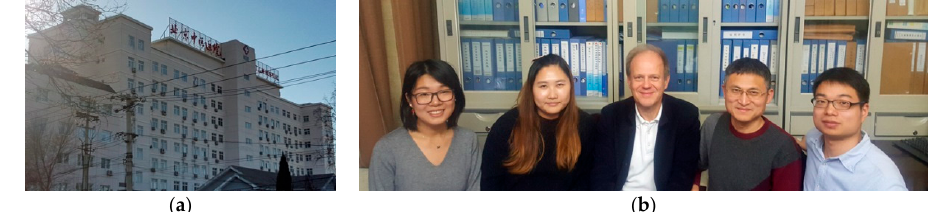
Figure 29. ( a ) Beijing Hospital of TCM affiliated to CMU; ( b ) The research team of the hospital with Professor Gerhard Litscher (middle) and Professor Liu Cun Zhi (middle right) in Beijing, 30